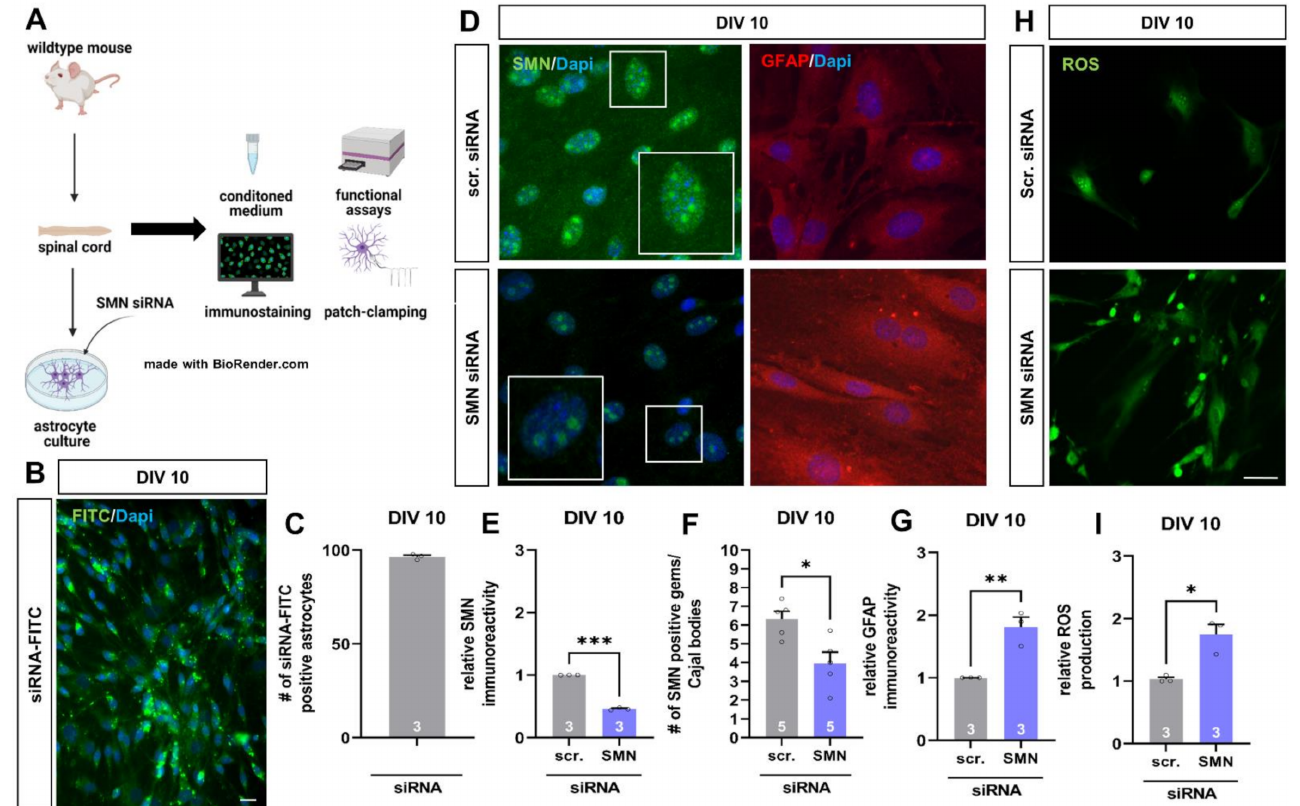
Figure 3. SMN-deficient spinal astrocytes can be generated by SMN siRNA in vitro, showing similar protein alteration as spinal astrocytes in the late-onset SMA mouse model. ( A ) Schematic drawing of the generation of SMA-deficient spinal astrocyte cultures by SMN siRNA and performed experiments. ( B ) Transfection of wild-type astrocyte cultures with scrambled siRNA-FITC (green) by magnetic transfection method. Nuclear DNA was stained with Dapi (blue). ( C ) Cultured wild-type astrocytes were successfully transfected with siRNA-FITC using the magnetic transfection method. ( D ) Im- munostaining of wild-type astrocyte cultures transfected with scrambled (scr.) or SMN siRNA against SMN protein (green) and GFAP (red) at DIV 10. In addition, nuclear DNA was stained with Dapi (blue). ( E ) Transfection of wild-type spinal astrocytes with SMN siRNA resulted in a reduction of SMN protein similar to the level observed in the juvenile SMA type III mouse model (***, p < 0.001). ( F ) SMN positive gems/Cajal bodies in the nucleus of astrocytes were reduced by transfection with SMN siRNA (*, p < 0.05). Furthermore, an increased number of GFAP-positive aggregate-like structures were